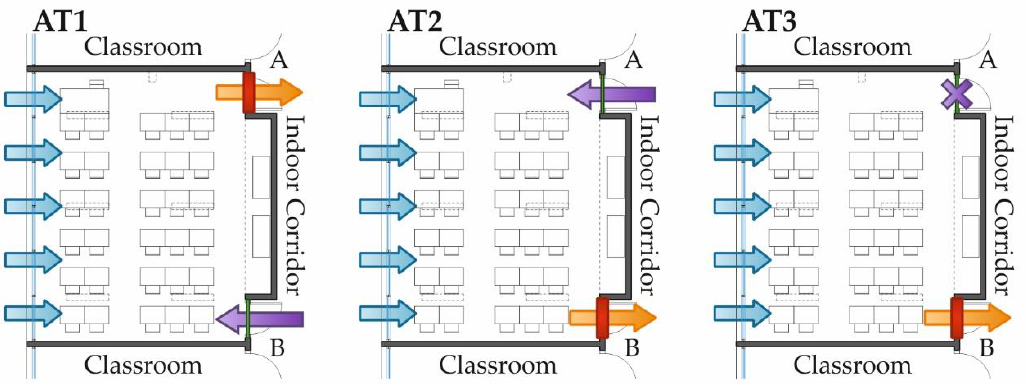
Figure 2. Protocols developed for the characterization of the airtightness of the classrooms.